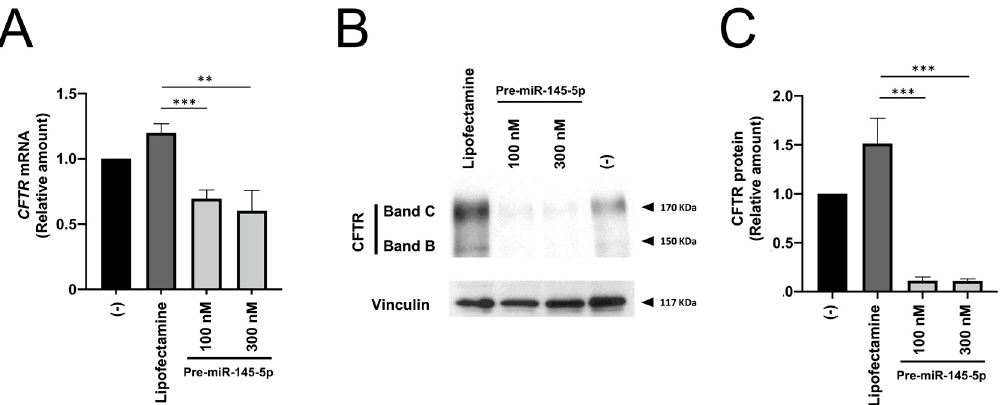
Figure 5. Effects of treatment of human intestinal Caco-2 cells with pre-miR-145-5p following protocol #1. ( A ). Relative amounts of CFTR mRNA (RT-qPCR) in pre-miR-145-5p treated Caco-2 cells. Treatment was 72 h. ( B ). Representative Western blotting. ( C ). Relative content of the CFTR protein. The uncut version of the gel is shown in Supplementary Figure S3. (-) = untreated cells. ** p < 0.01, *** p < 0.001.